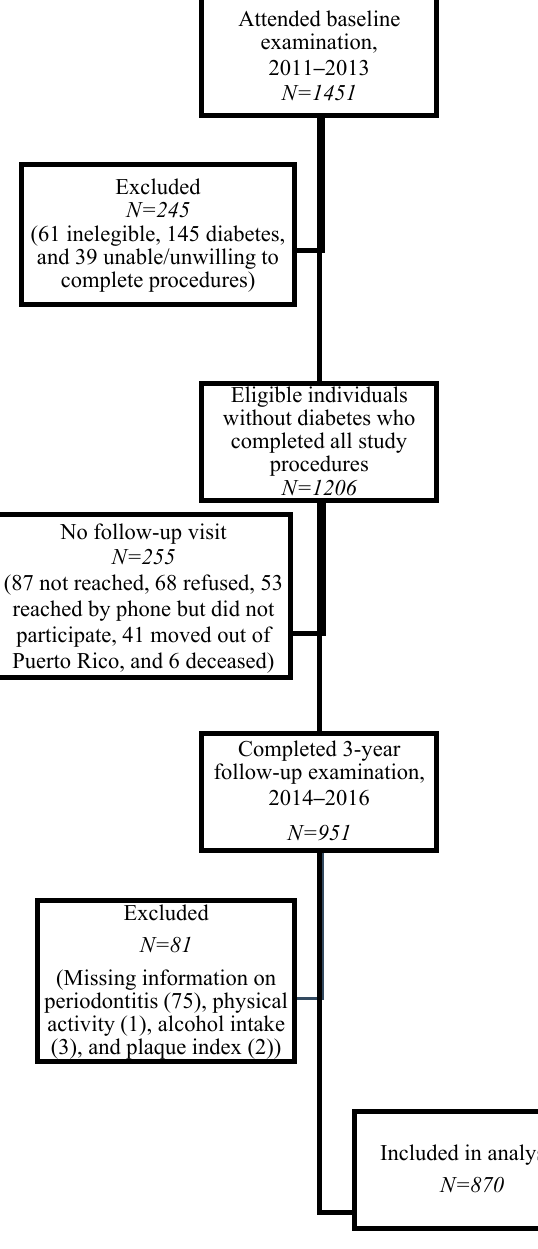
Figure 1. Flow of participants through the study (N = 870).